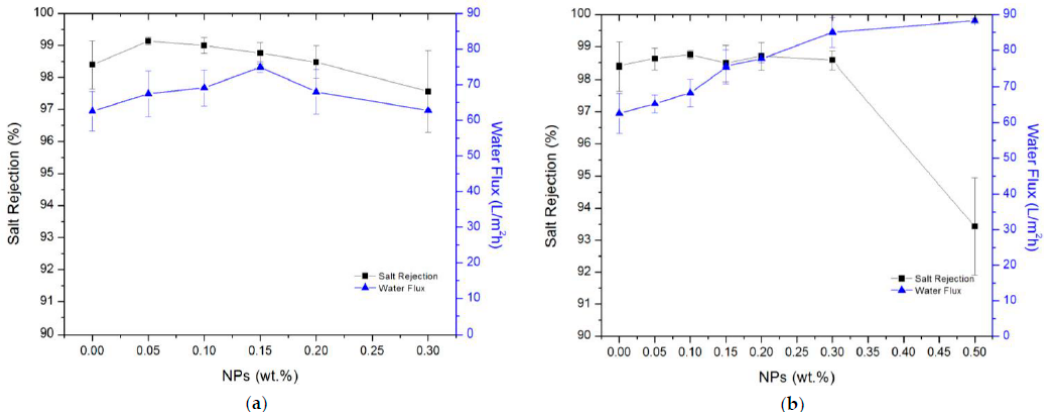
Figure 12. TFN membrane desalination performance filled with ( a ) UiO-66 and ( b ) MIL-125 [42].